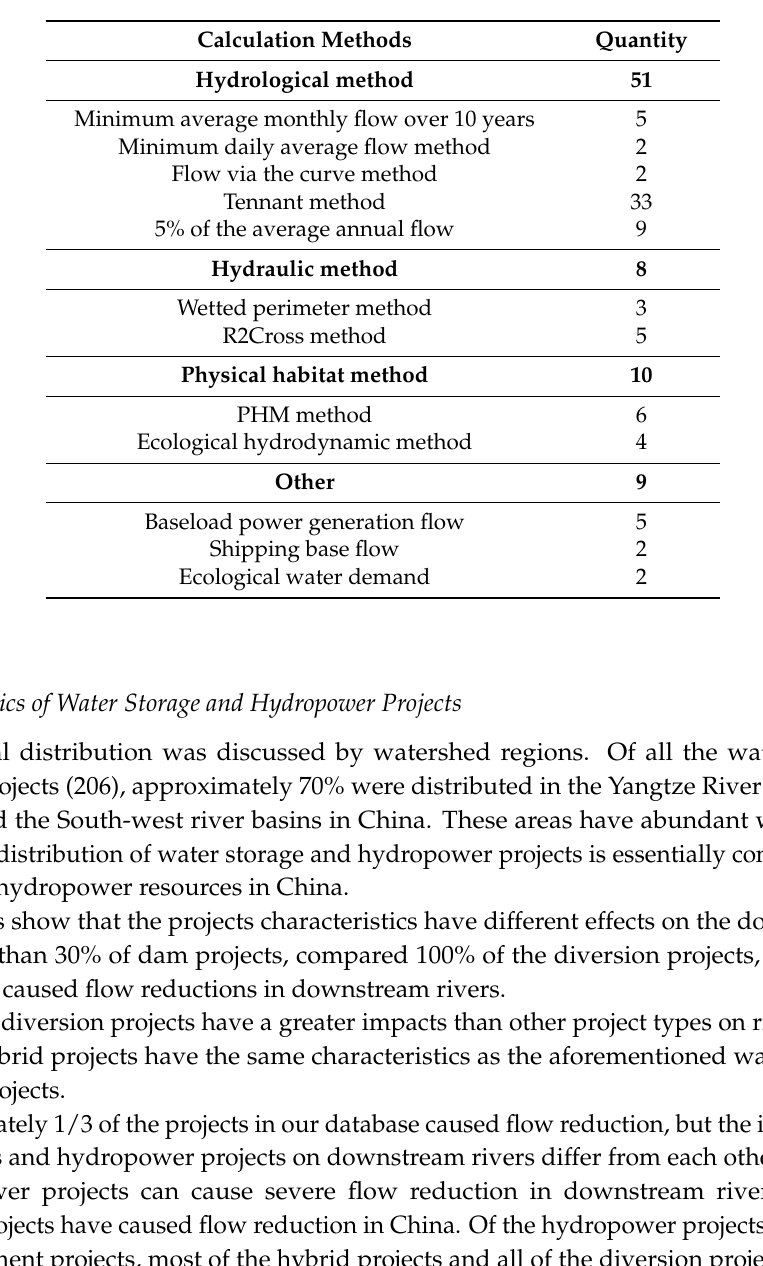
Table 5. Calculation methods and statistics for ecological